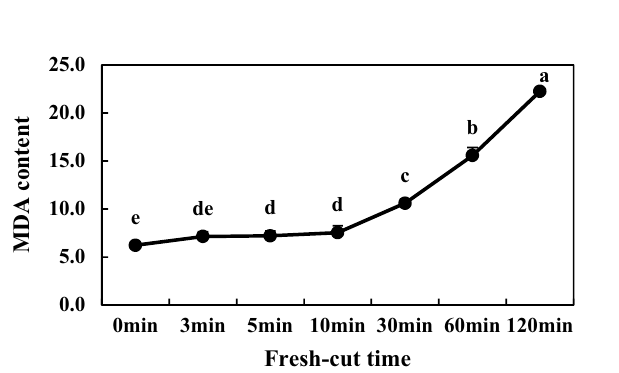
Figure 7. Rate of O 2 · − production of Fresh-Cut eggplants.